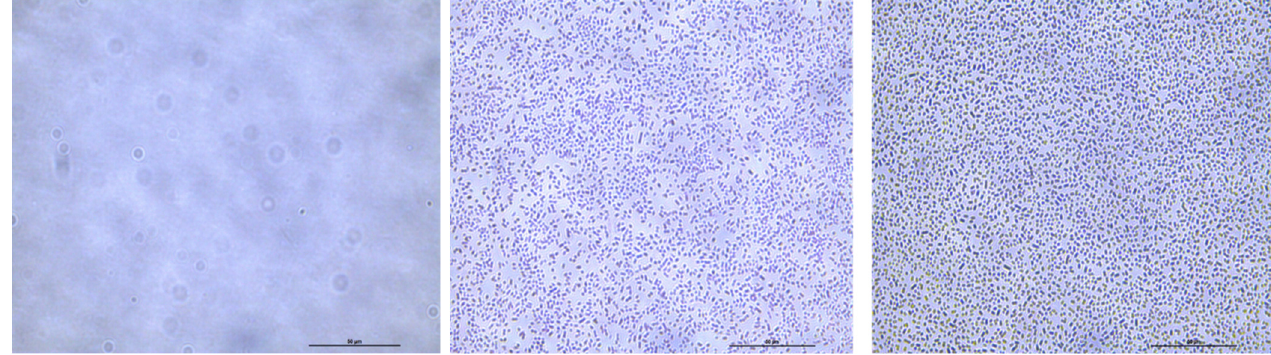
Figure 6: Crystal violet Staining of K. pneumoniae Biofilm